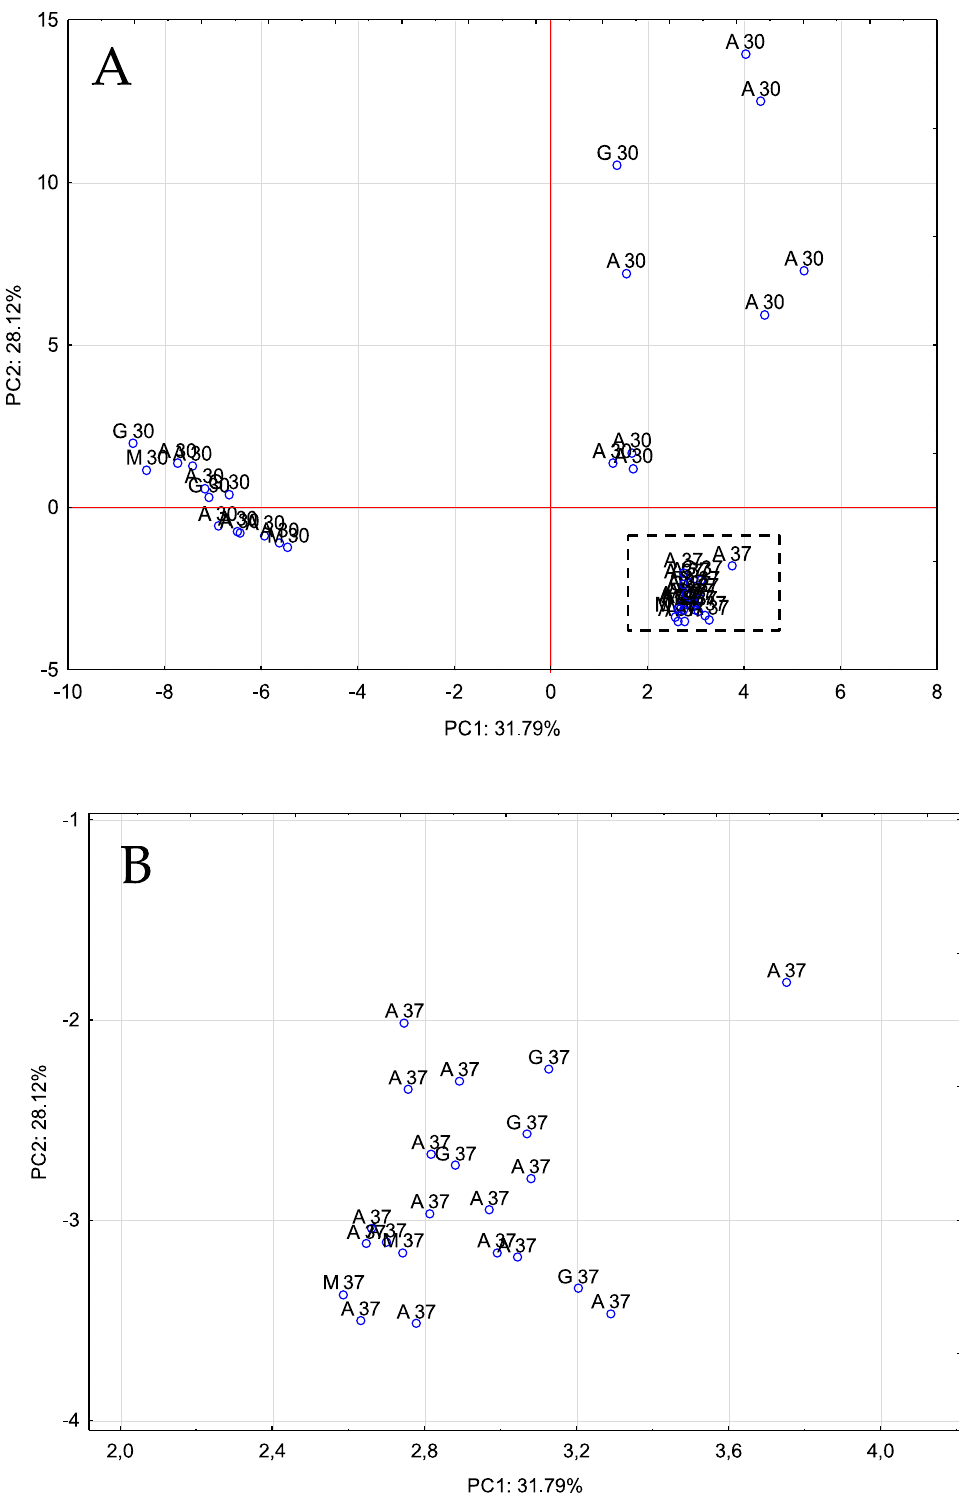
Figure 2. PCA on volatile compounds. Distribution of all vinegar samples onto the plane defined by the first two PCs. ( A ): original graph; ( B ): zoomed area. A 30/A 37: Acetobacter at 30 °C and 37 °C, G 30/G 37: Gluconobacter at 30 °C and 37 °C, M 30/M 37: Mixture of bacteria at 30 °C and 37 °C.